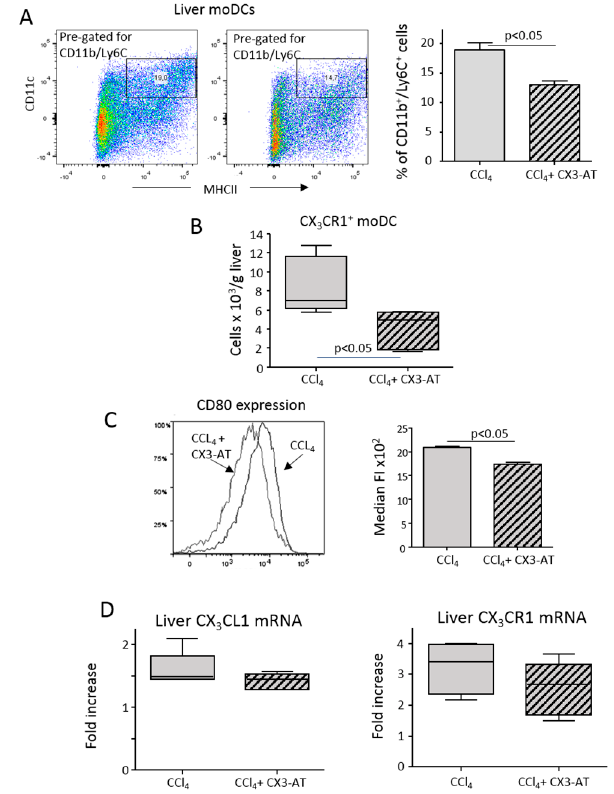
Figure 6. The CX 3 CL1 antagonist CX3-AT reduces the expansion of monocyte-derived dendritic cells (moDCs) in response to hepatic injury. Liver dendritic cells were analyzed by flow cytometry in mice receiving CCl 4 alone or in combination with CX3-AT. ( A , B ) Liver distribution of CD11b + / Ly6C + moDCs and CX 3 CR1-expressing moDCs. ( C ) Plasma membrane expression of the maturation marker CD80 in moDCs for CCl 4 -treated mice receiving or not receiving CX3-AT. The values are expressed as means ± SD of three different cell preparations. ( D ) RT-PCR analysis of the hepatic transcripts for CX 3 CL1 and CX 3 CR1. The values are expressed as fold increase over control levels and are means ± SD of 6–8 animals in each experimental group.